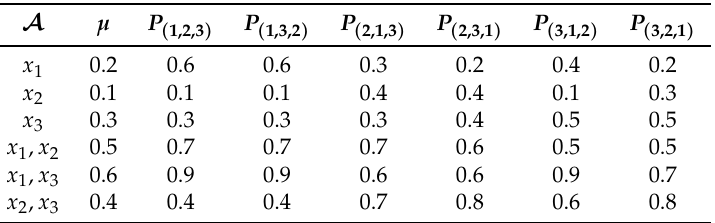
Table 1. A fuzzy measure and the associated probability distributions corresponding to all the possible permutations of the indices ( 1,2,3 )